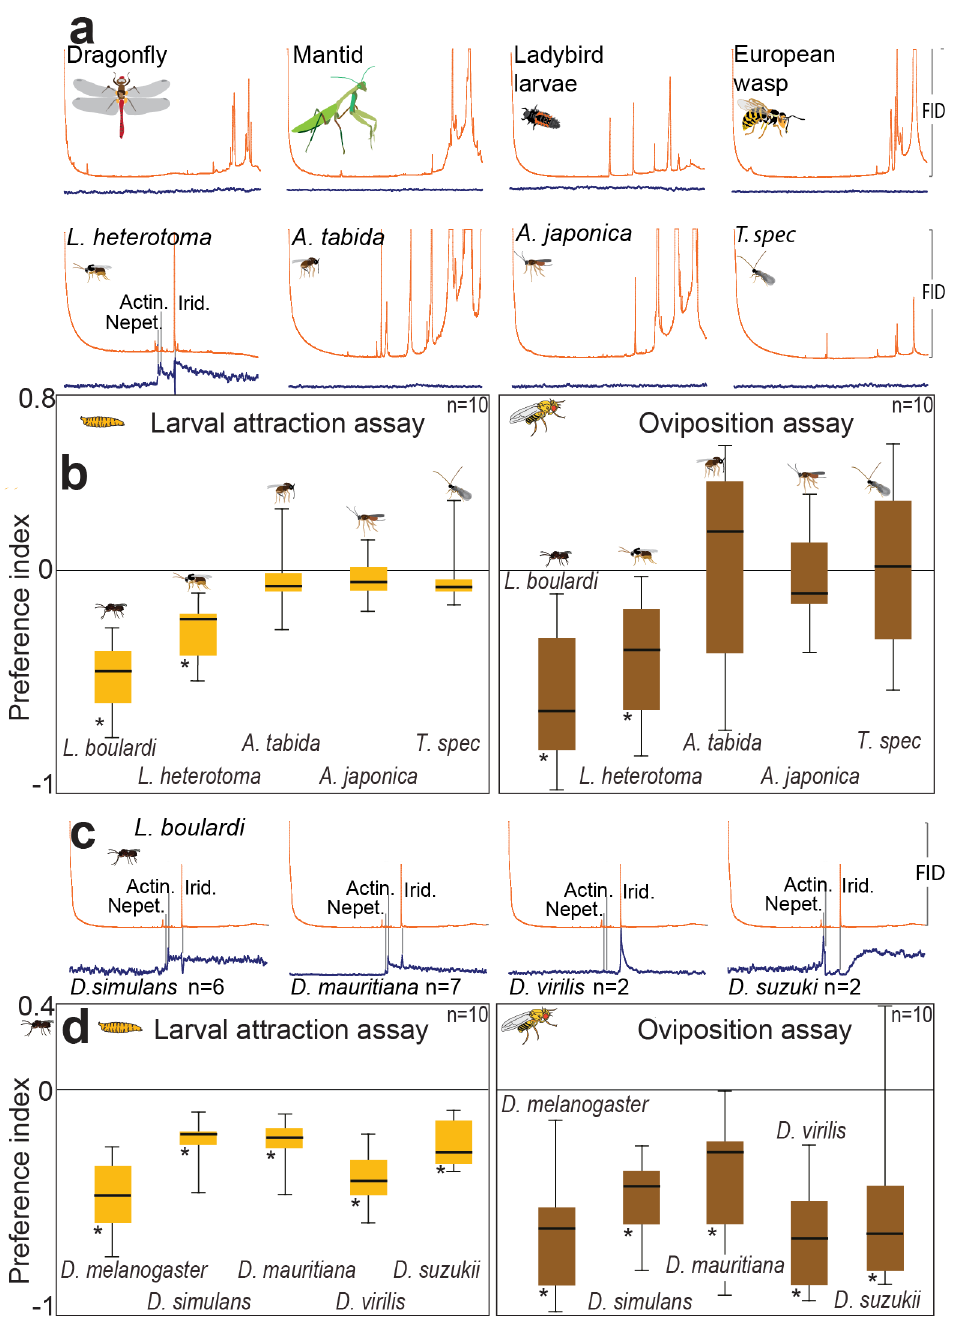
Fig 5. The ab10B neuron detects Leptopilina odors only, and detection and avoidance of Leptopilina odor are conserved within many drosophilid flies. ( A ) Example spike traces of GC-coupled SSR recordings of D . melanogaster ab10B neurons with washes of four potential predators (top row) and four parasitoid wasp species (bottom row). ( B ) Preference indices of D . melanogaster larvae and ovipositing females when tested with washes of five parasitoid species. Note that only washes of L . boulardi and L . heterotoma contain ligands of the ab10B neuron and provoked avoidance behavior in D . melanogaster . ( C ) Example spike traces of GC-coupled SSR recordings of ab10B neurons of 5 different Drosophila species with washes of L . boulardi . ( D ) Preference indices of larvae and ovipositing females of 5 Drosophila species tested with wash of L . boulardi . ( A – B ) Deviations of indices against zero were tested with Wilcoxon rank sum test. Asterisks, p < 0.05; error bars depict standard